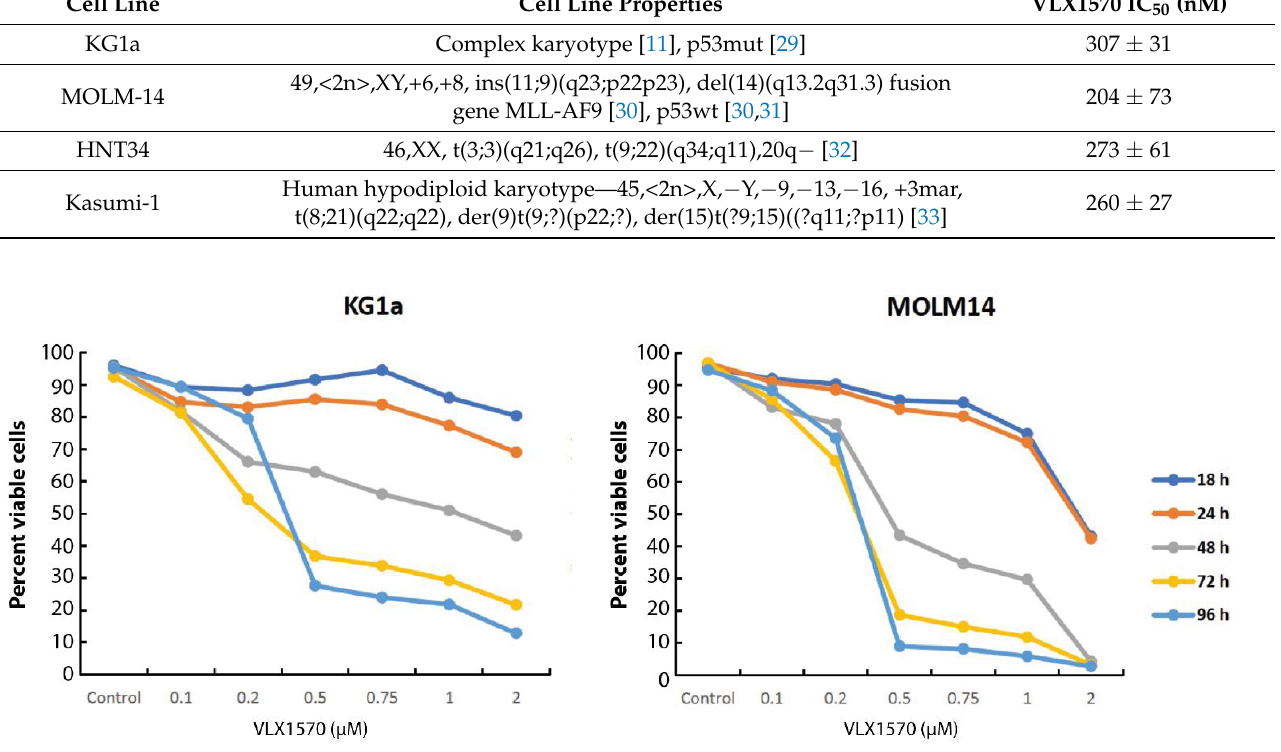
Figure 2. Time- and dose-dependent loss of viability of MOLM-14 and KG1a cells exposed to VLX1570. Cell viability was determined using acridine orange/propidium iodide staining. Table 3. AML cell lines used in the present study.